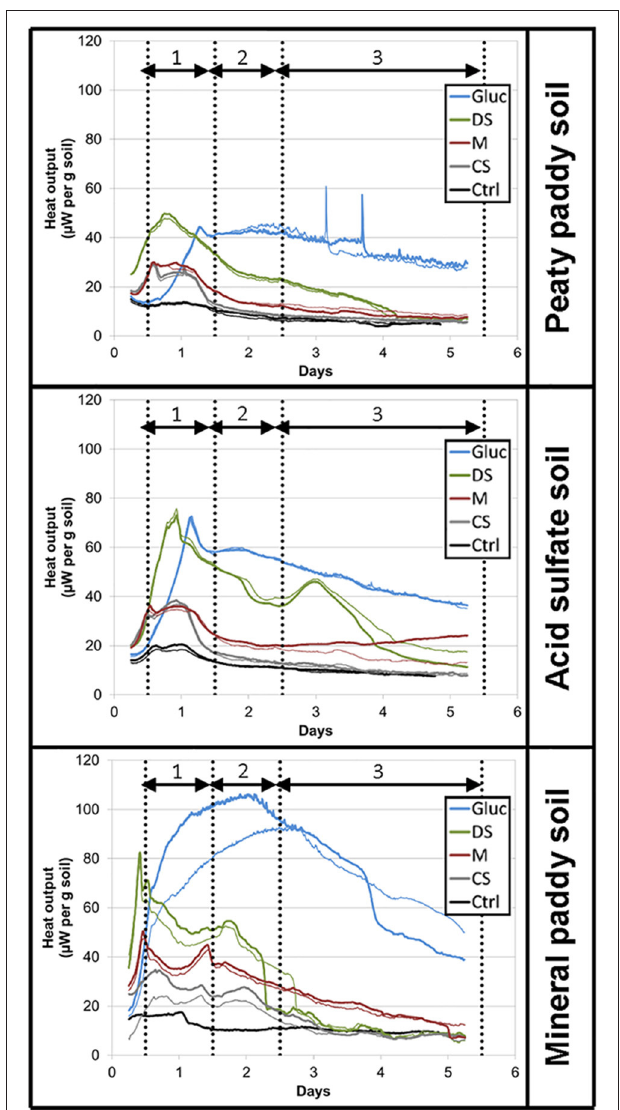
FIGURE 3 | Heat flow ( µ W per g soil) over the course of the 5-day incubation. Colors represent treatments: Control, black; CS, gray; M, red; DS, green; Gluc, blue. Duplicate vials are depicted by thick and thin lines. Vertical dotted lines indicate sampling times for the respiration measurements.